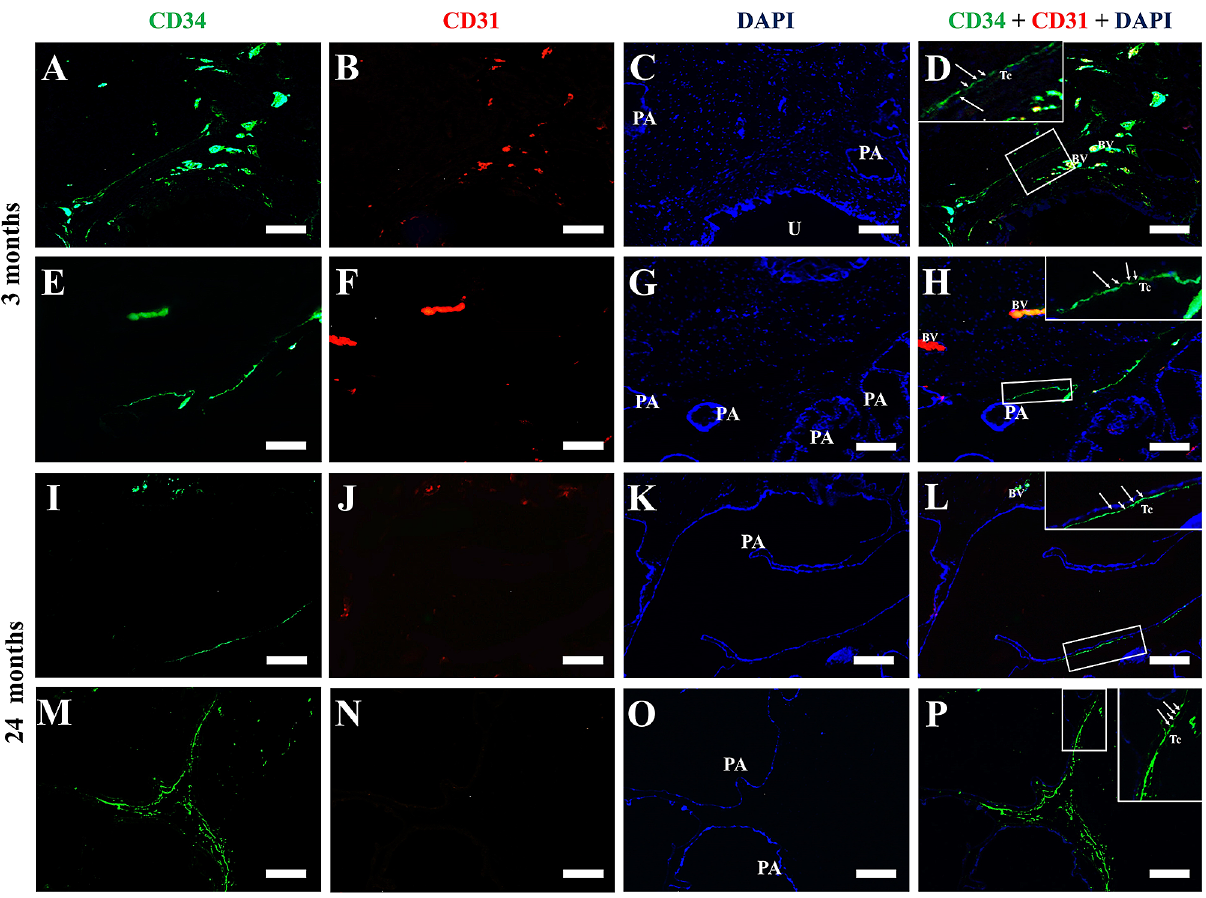
animals (3 months of age) is found dispersed in the prostate stroma in blood vessels, in which it colocalizes with CD31. It is possible to verify a telocyte in the prostate stroma, which is CD34-positive and CD31- negative, it has a long CD34-positive telopode. ( E – H ) Another telocyte is observed, with a telopode reaching a prostatic alveolus. ( I – L ) In the prostate of senile animals (24 months of age), it is possible to observe